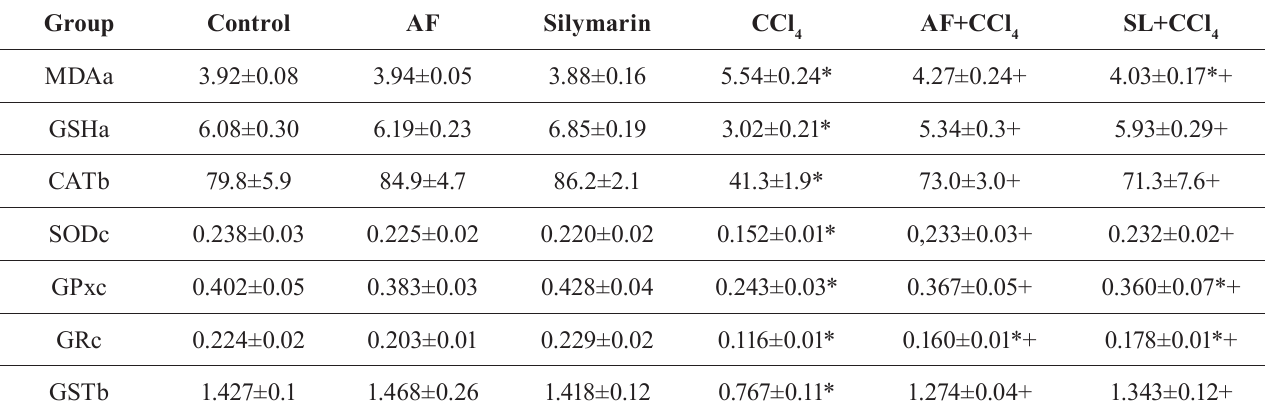
TABLE II - Effect of AF and silymarin (SL) treatment on hepatic liver peroxidation and antioxidant profile in rats challenged with CCl4 Group